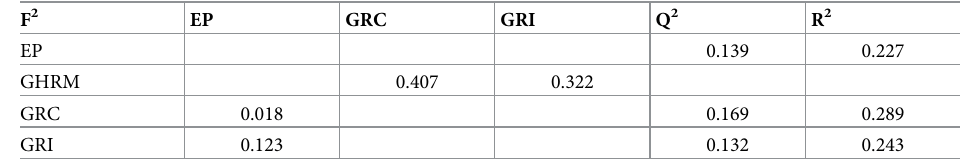
Table 6. Predictive relevance (Q 2 ) and effect size (f 2